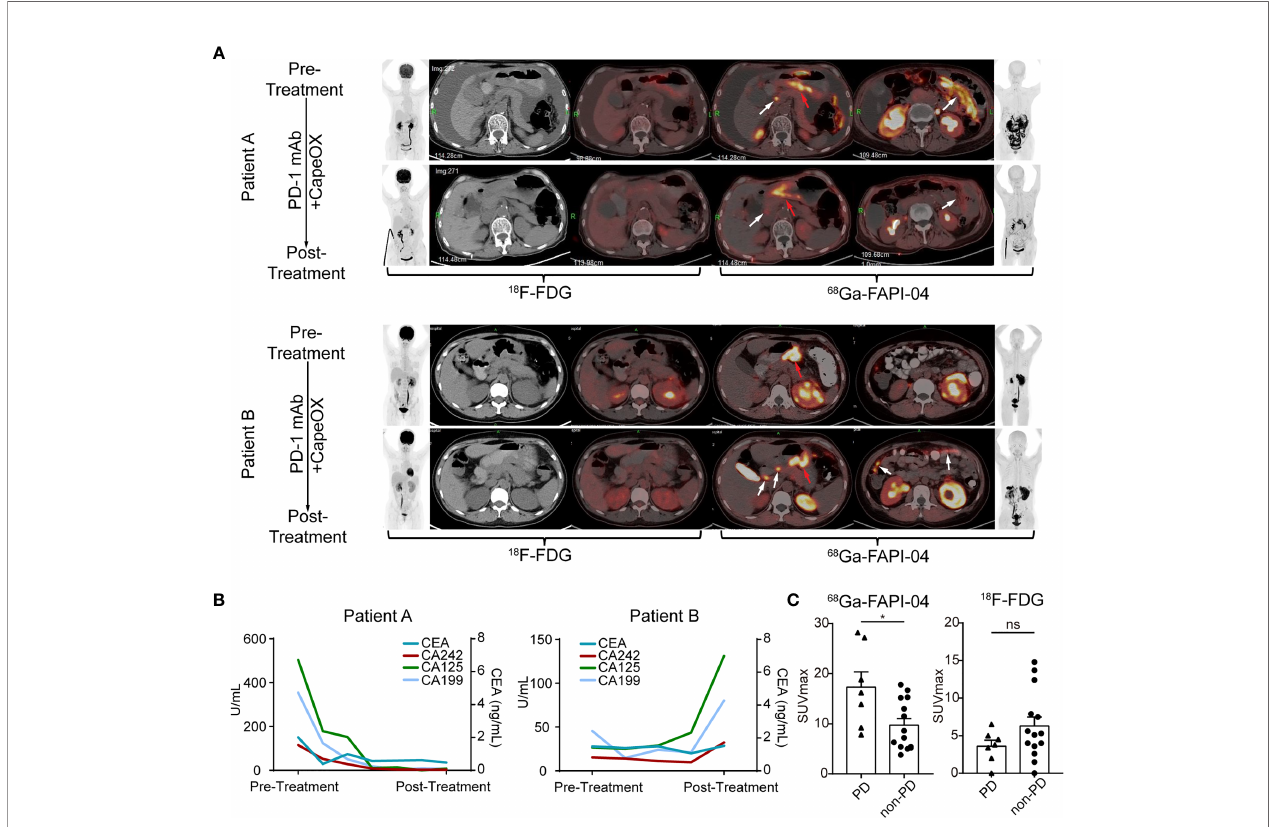
FIGURE 5 | FAPI uptake predicts the immunotherapy response in GC. (A) (Patient A) Images of a 71-year-old female with gastric adenocarcinoma, that was sensitive to immunotherapy show low uptake of 68 Ga-FAPI-04. The ef fi cacy was con fi rmed by the reduced levels of ascites and the decreased uptake of 68 Ga-FAPI- 04 (red arrows, primary lesions; white arrows, metastatic lesions). (Patient B) Images of a 36-year-old female with gastric adenocarcinoma that was not sensitive to immunotherapy show high uptake of 68 Ga-FAPI-04. The new metastatic lesions appear after immunotherapy (white arrows). Pretreatment and posttreatment images obtained at 18 F-FDG and 68 Ga-FAPI-04 PET/CT of GC patient. (Left: anterior maximum intensity projection image, axial unenhanced CT image, axial fused 18 F-FDG image. Right: axial fused 68 Ga-FAPI-04 PET/CT image, anterior maximum intensity projection image). (B) The curve of serum tumor markers of GC patients. Patient A who was sensitive to immunotherapy showed the decrease of serum tumor markers after treatment while patient B who was not sensitive to immunotherapy displayed increase of serum tumor marker. (C) SUVmax of 68 Ga-FAPI-04 and 18 F-FDG in gastric adenocarcinomas with different prognoses. Signi fi cant differences in SUVmax of 68 Ga-FAPI-04 were detected between the PD and non-PD group (* p < 0.05, ns, no signi fi